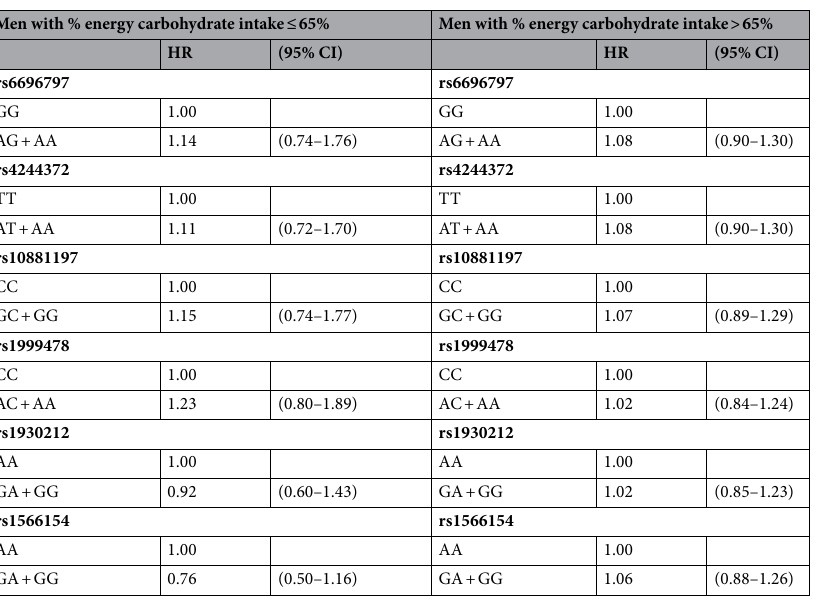
Table 3. Adjusted hazard ratios (and 95% CIs) for associations between AMY1 SNPs and incidence of type 2 diabetes, stratified by carbohydrate intake in Korean men. Adjusted for age (years), area of residence (Ansan or Ansung), education level [elementary school or lower (< 7 years completed), middle/high school (7–12 years), college or higher (> 12 years)], smoking status (never, former smoker, current smoker), alcohol consumption (g/day), physical activity [metabolic equivalent task (MET)-h/week], body mass index (BMI; kg/m 2 ), and family history of diabetes (self-reports: yes, no). HR hazard ratio, CI confidence intervals.